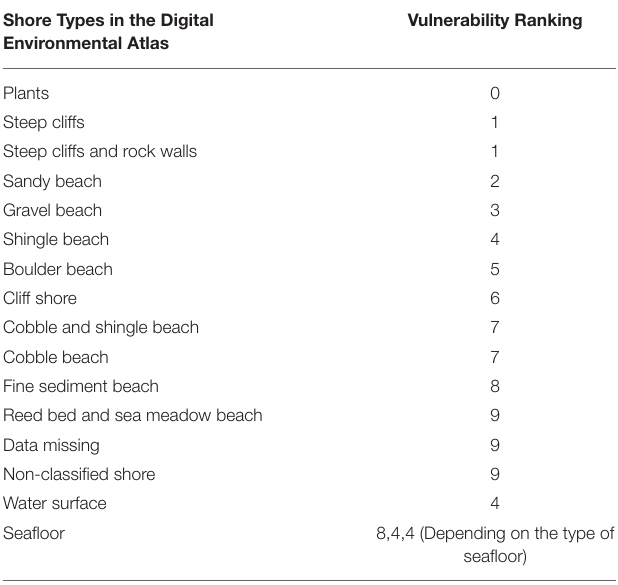
TABLE 2 | Vulnerability ranking for shore types, water surface and seafloor. Shore Types in the Digital Environmental Atlas